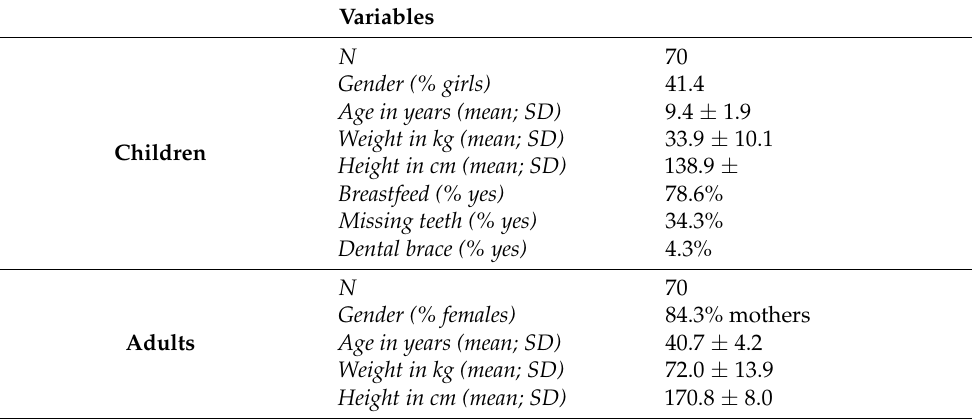
Table 1. Characteristics of the